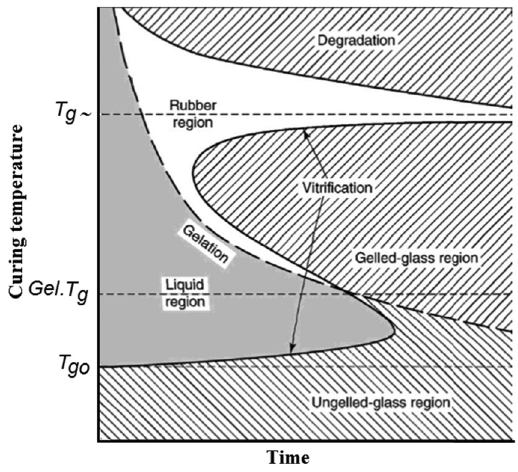
Figure 9: TTT diagram of isothermal curing process for the thermoset system [ 44 ]